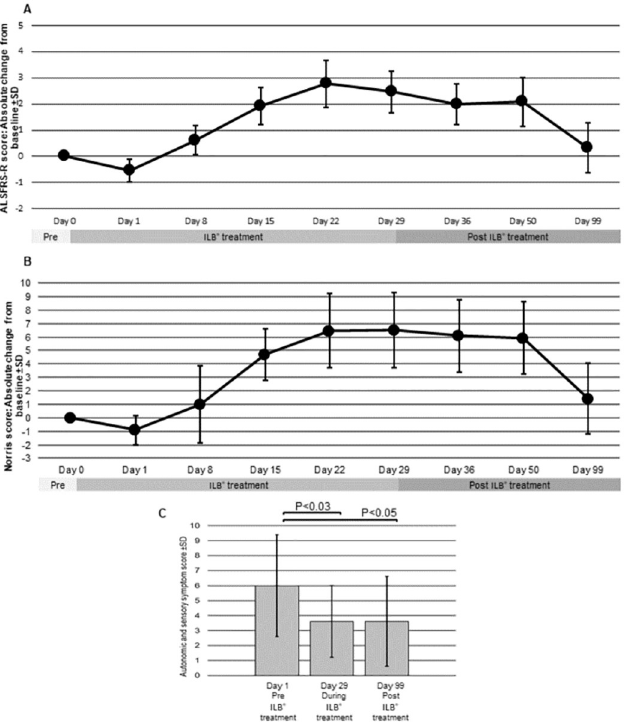
Fig 5. Changes in the (A) ALSFRS-R, (B) Norris and (C) autonomic/sensory symptom scores from baseline (N = 13; Mean ± SD). A rising ALSFRS-R and Norris score indicates functional improvement. Conversely, a falling autonomic/sensory symptom score indicates symptom improvement.